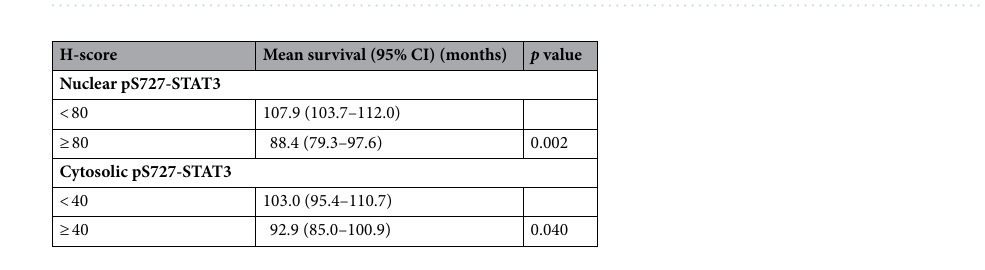
Table 4. Overall survival of ccRCC patients considering the expression of